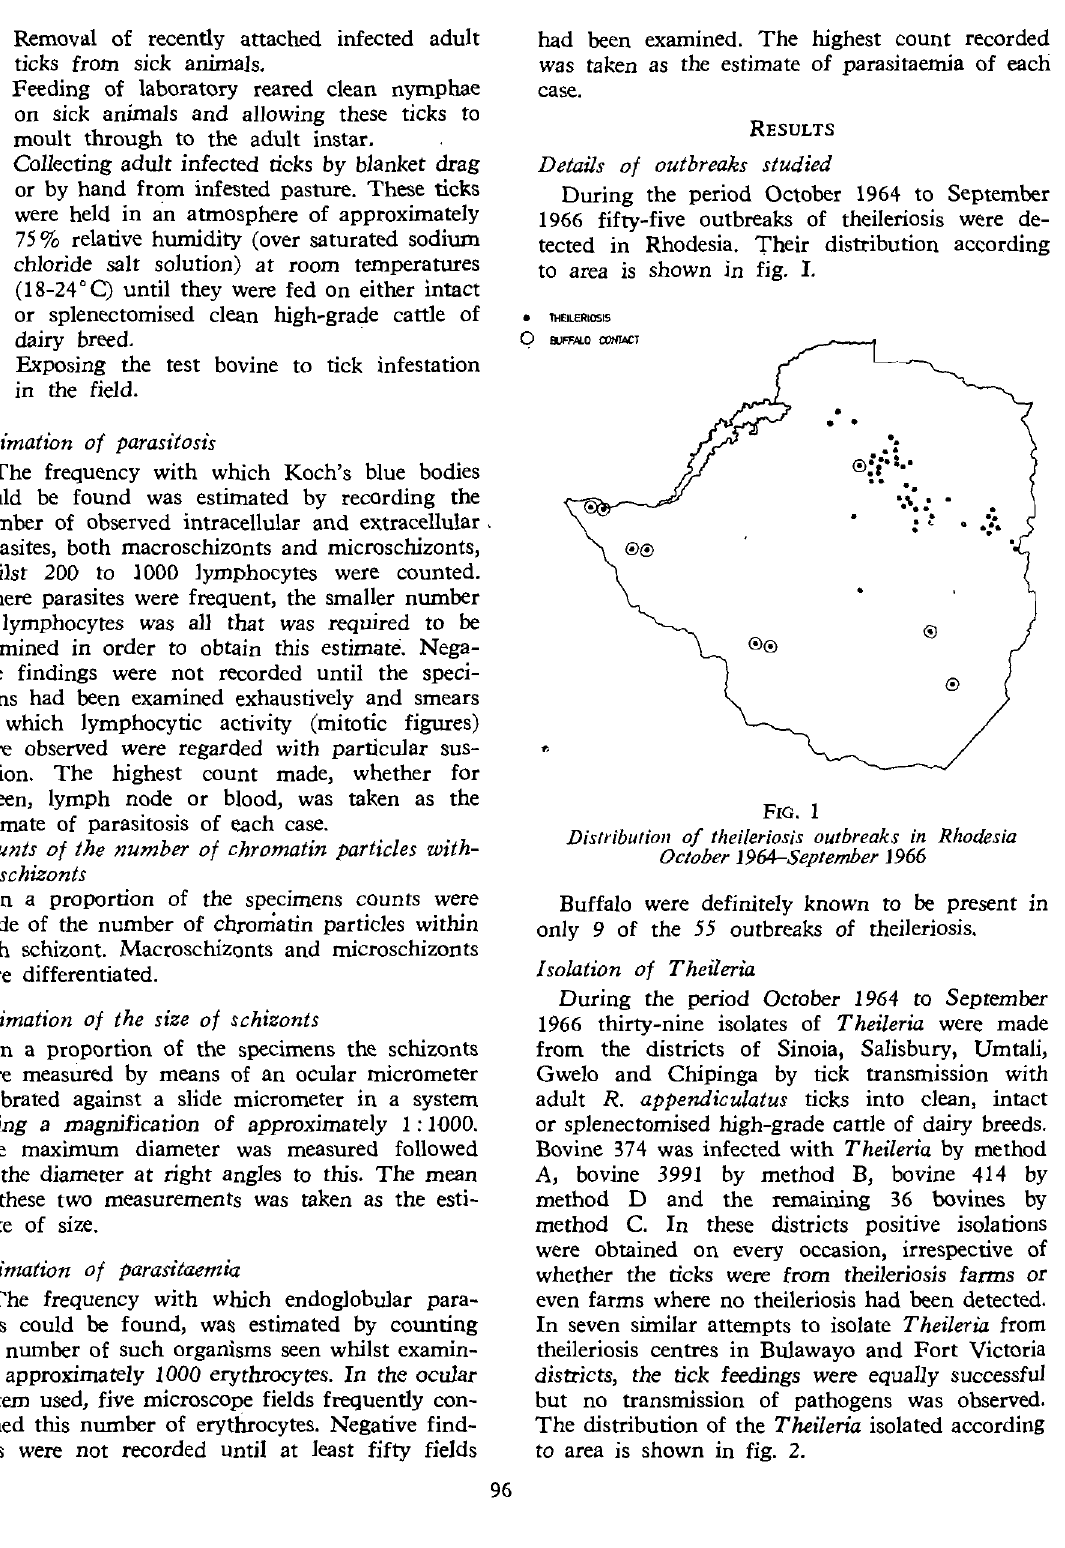
FIG. 1 Distribution of theileriosis outbreaks in